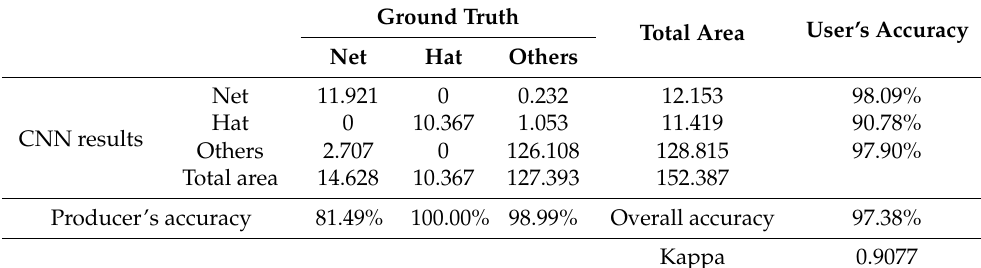
Table 6. Accuracy assessment of cultivation field-based mapping of sunscreen mature fruits (Unit: ha). Ground Truth